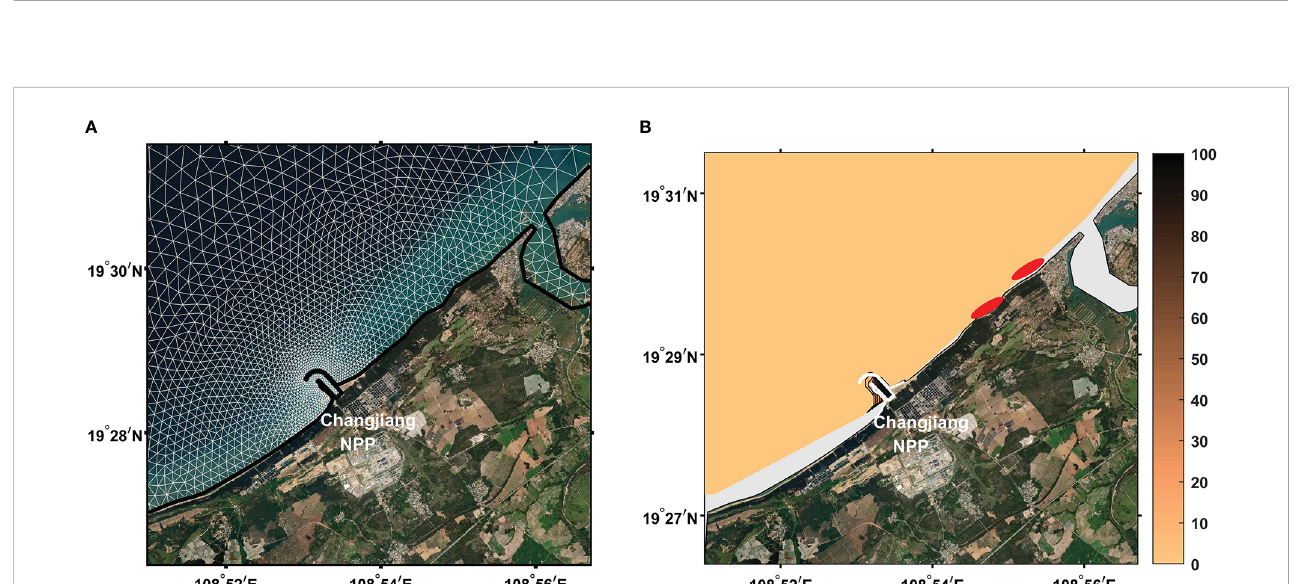
FIGURE 6 (A) Computational grid in the study region (white line) for the new model case. (B) Probabilistic intensity distribution calculated from outputs of the new model case, which yields the same result for all particle-tracking simulations. The two red elliptical markers indicate the locations of two gulfweed source sites near the coast.